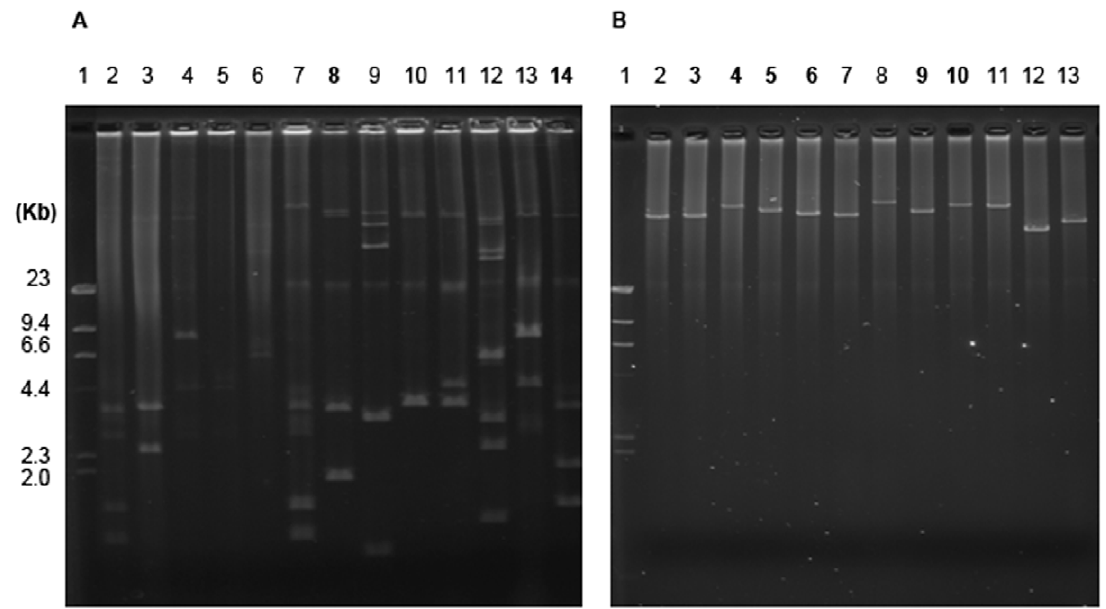
Figure 2. Plasmid profiles of representative MDR isolates and plasmid from transformants. A ) Plasmids from representative wild MDR isolates. Lane 2: # 26*; Lane 3: # 144 ; Lane 4: # 145; Lane 5: # 199; Lane 6: # 201; Lane 7: # 25; Lane 8 : # 432 ; Lane 9: # 543; Lane 10: # 547; Lane 11: # 548; Lane 12: # 782; Lane 13: # 155 and Lane 14 : # 257 . B ) Plasmids from transformants of wild isolate plasmid extractions. Lane 2: # A** 2 150 ( , 70 kb); Lane 3: # A-257 ( , 72 kb); Lane 4: # G-257 ( , 98 kb); Lane 5: # A-432 ( , 98 kb); Lane 6: # G-432 ( , 87 kb) ; Lane 7: # A-546 ( , 88 kb); Lane 8: # A-351( , 100 kb); Lane 9: # A-638 ( , 77 kb); Lane 10: # G-638 ( , 78 kb); Lane 11: # A-120 ( , 72 kb); Lane 12: # A-289 ( , 52 kb) and Lane 13: # A- 575 ( , 49 kb) (Plasmids sizes were estimated by the Eco RI restriction enzyme digestion, Material and Methods: Plasmid Size Determination.) Both pane1s include the lambda Hin dIII DNA size marker in Lane # 1. Numbers in bold represent two plasmids carrying multiple drug resistant genes in a single strain;*: strains number of wild parent strains from which -drug resistance plasmids are (their extracted plasmid transformants share the same strain # ); **‘‘A’’: ampicillin resistant transformant; ***‘‘G’’: gentamicin resistant transformant.